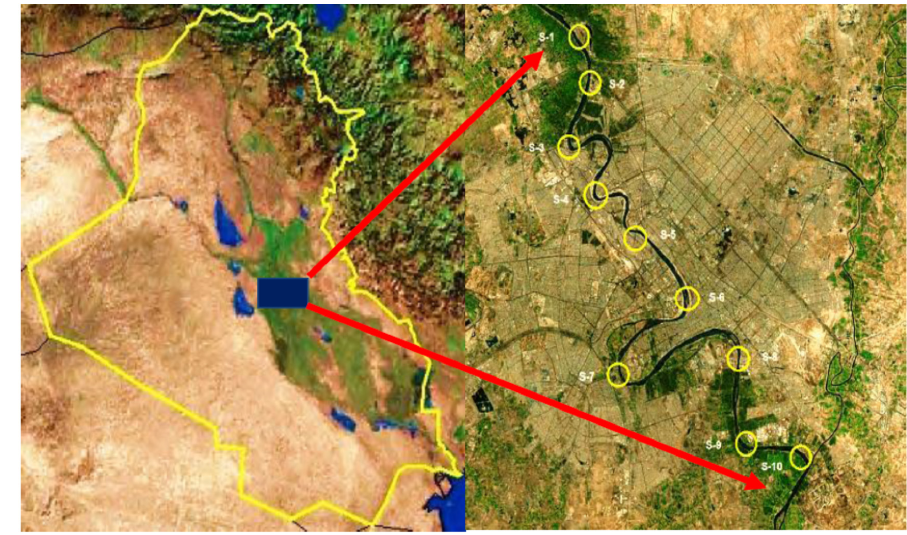
Figure 1. The sampling stations on the Tigris River in Baghdad.